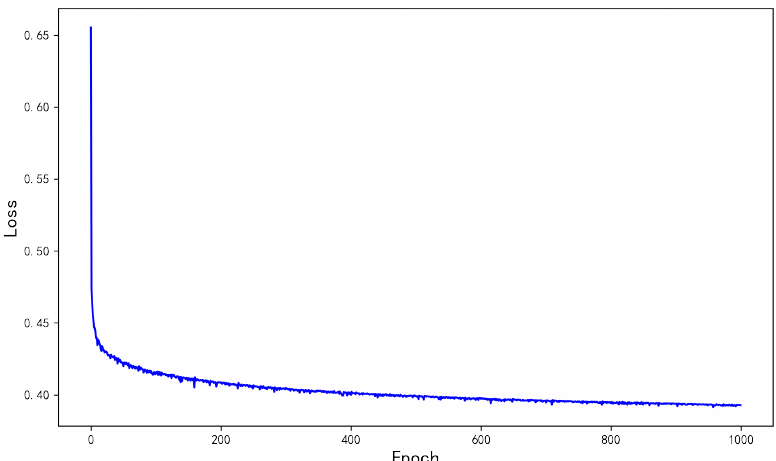
Figure 2. Training process for Estate dataset when learning the rate is 0.001.